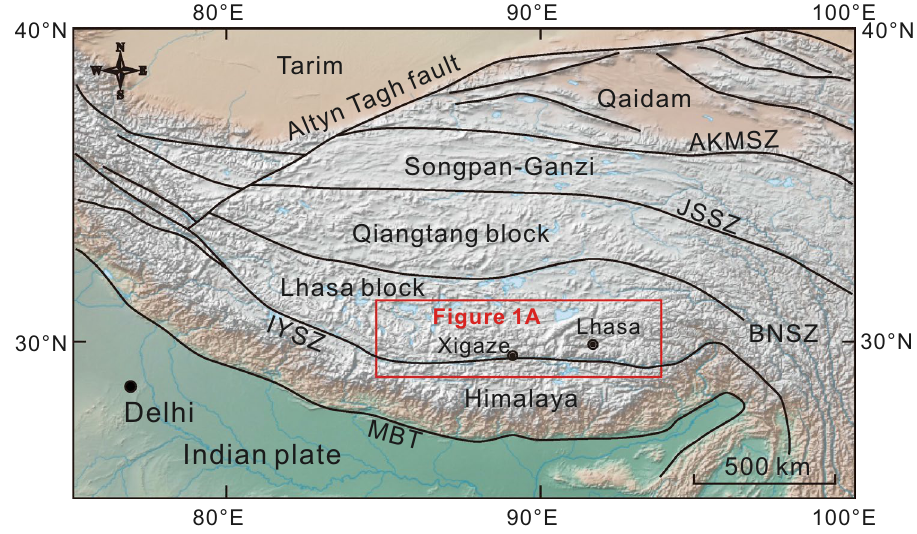
Figure 1. Tectonic and geomorphic map of the Himalayan–Tibetan orogen showing major tectonic units. Base map is made with Natural Earth (https:// www. natur alear thdata. com). The map was modified by Zongyao Yang, using CorelDRAW X8 version 18.0.0.448. AKMSZ Anyimaqen–Kunlun–Muztagh suture zone, JSSZ Jinsha suture zone, BNSZ Bangong–Nujiang suture zone, IYSZ Indus–Yarlung suture zone, MBT Main boundary